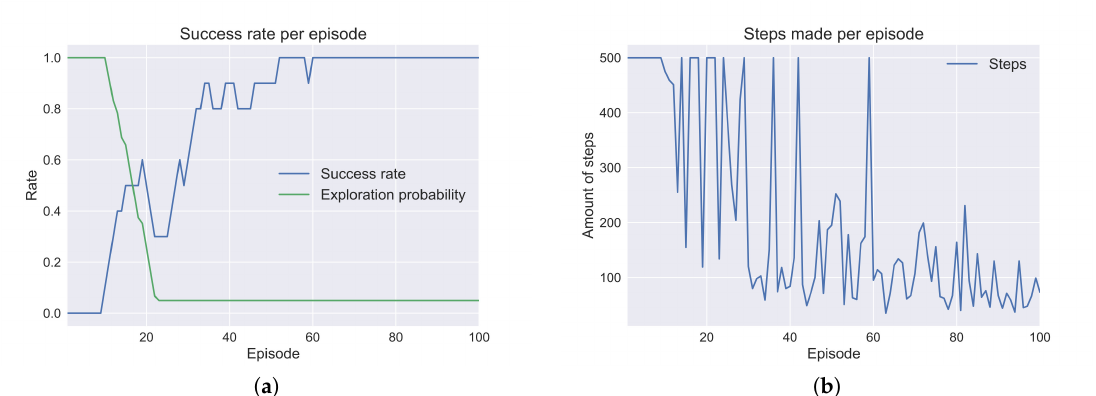
Figure 6. Results of training the real robot from scratch to learn how to fold a smart textile. ( a ) The folding success rate and exploration probability per episode. The success rate grows to 100% after training for 8 h on the real robot. ( b ) The amount of steps required per episode to solve the task; the amount of motor commands needed to fold the cloth decreases after relatively few training